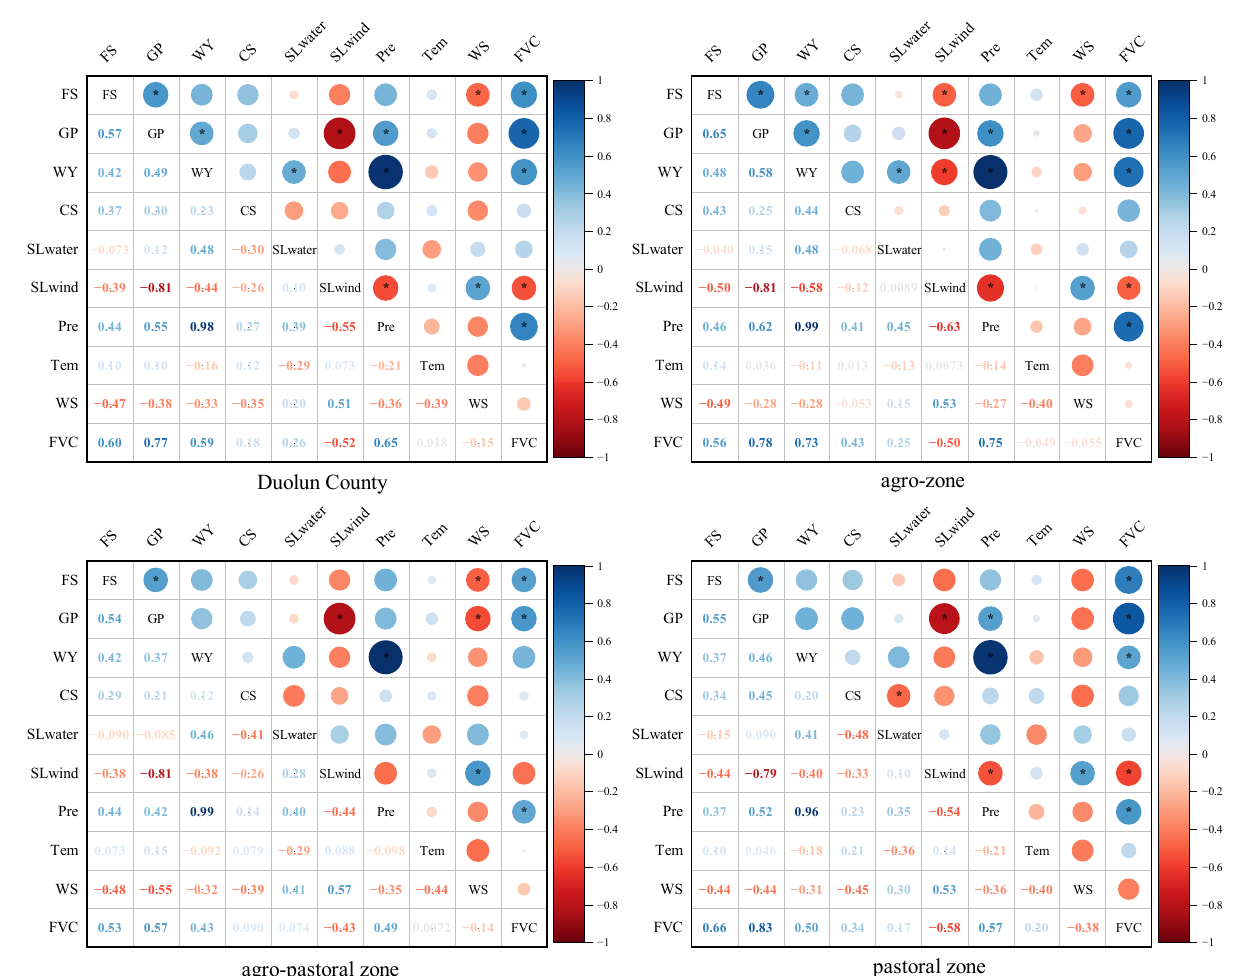
Figure 6. Correlation analysis between the ESs and the four drivers (vegetation cover (FVC), precip- itation (Pre), temperature (Tem), and wind speed (WS)) in different regions from 2000 to 2017. The blue and red circles above the diagonal indicate positive and negative correlations, respectively. The asterisks in the circles show the significance degree ( ∗ for p < 0.05). The numbers below the diagonal indicate Spearman’s correlation coefficients, with their color matching those of the corresponding circles. Darker colors demonstrate stronger correlations. FS: food supply, GP: grass production, WY: water yield, CS: carbon sequestration, SLwater: soil water erosion, SLwind: soil wind erosion. agro- zone: the agricultural advantage zone, pastoral zone: the pastoral advantage zone, agro-pastoral zone: the semiagricultural and semipastoral zone. Combined with the results of partial correlation analysis (Figure 7): (1) FVC was sig- nificantly and positively correlated with FS and GP, whereas WS showed a negative cor- relation with FS and GP; (2) the correlation between Pre and WY was still significant and positive, but the correlation between FVC and WY became significantly negative from significantly positive; (3) the relationship between CS and drivers did not change, but the driver with the greatest correlation between CS in agro-zone, pastoral zone, and agro- pastoral zone was different, namely, Pre, WS, and WS; (4) FVC and SLwater changed from a positive correlation to a negative correlation, whereas Pre and SLwater were still posi- tively correlated; (5) Tem and WS were significantly and positively correlated with SLwind, whereas Pre and FVC were still negatively correlated with soil wind erosion.